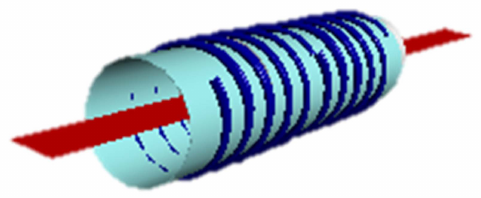
Figure 10. Three-dimensional image of sprout/PANI.